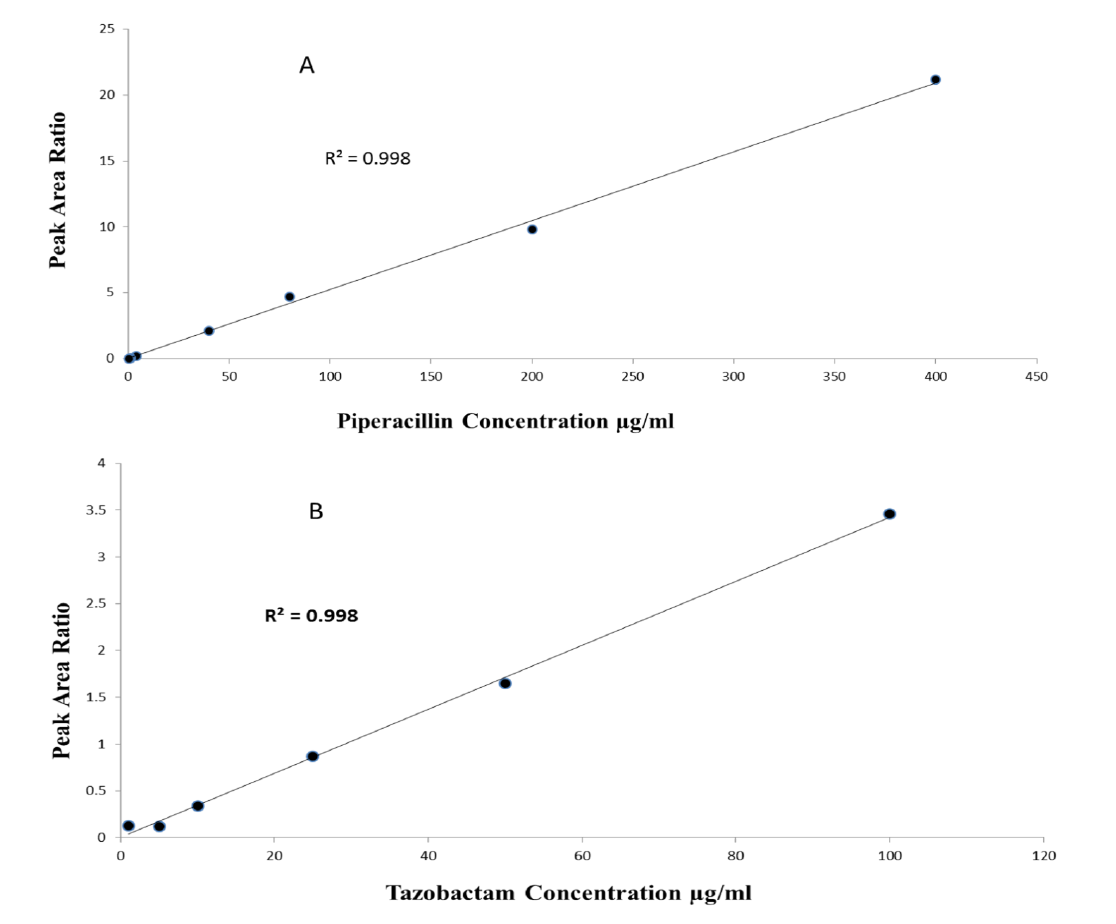
Figure 3. ( A ) Linearity of piperacillin over range of 0.5–400 µg/mL; ( B ) linearity of tazobactam over range of 1–100 µg/mL.